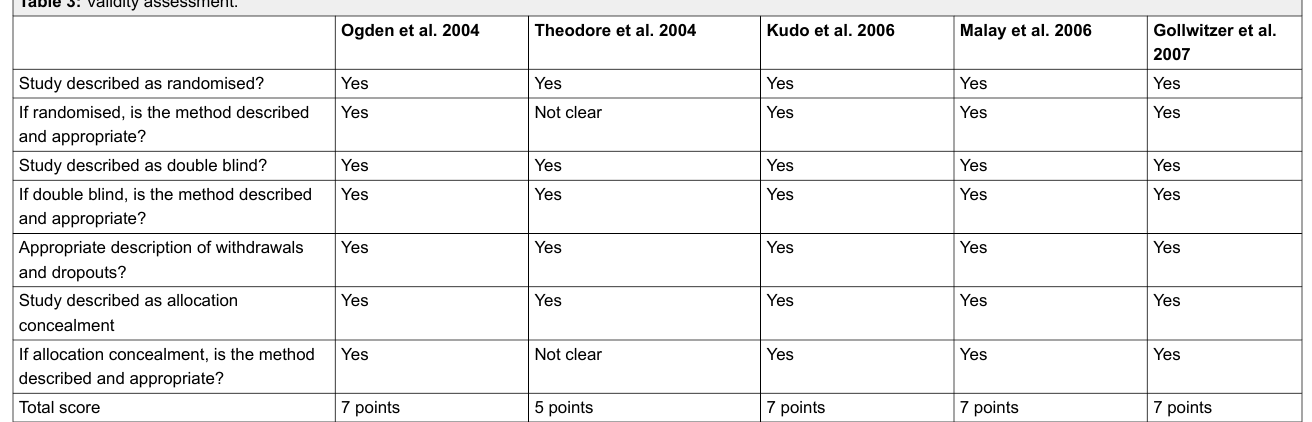
Table 3: Validity